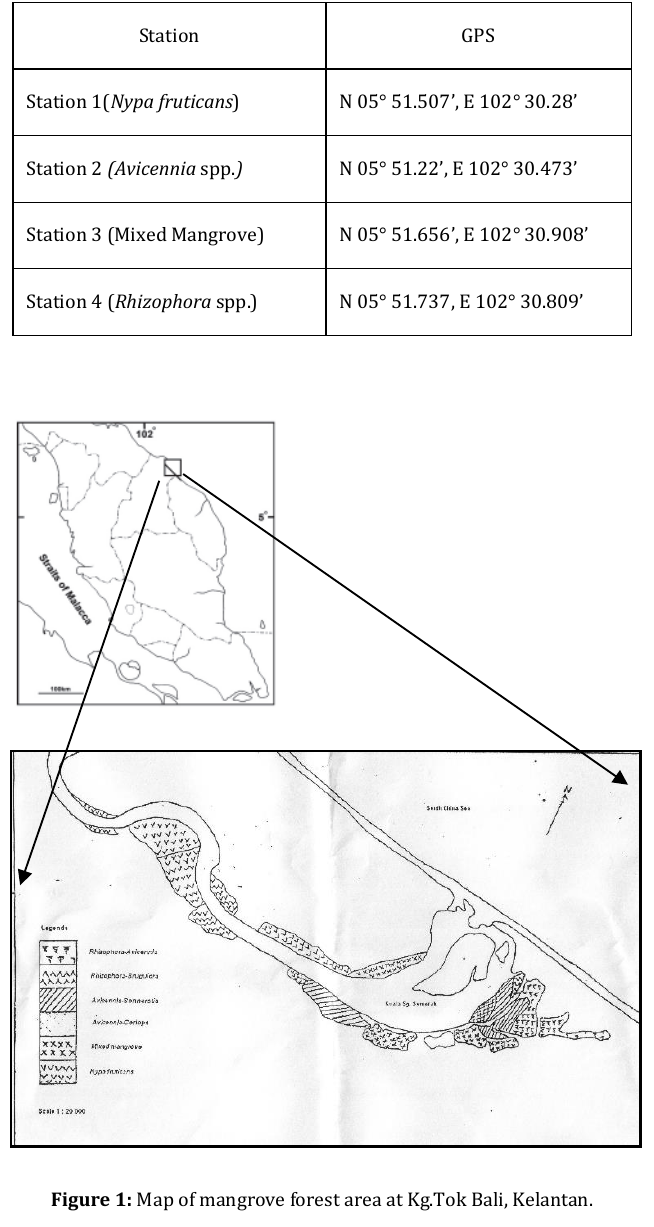
Figure 1: Map of mangrove forest area at Kg.Tok Bali,